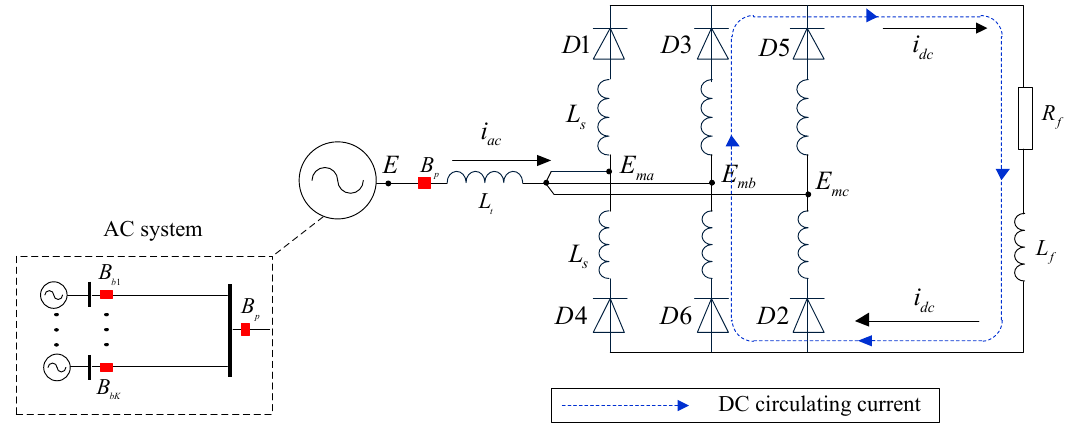
Figure 4. Schematic diagram of DC circulating current.